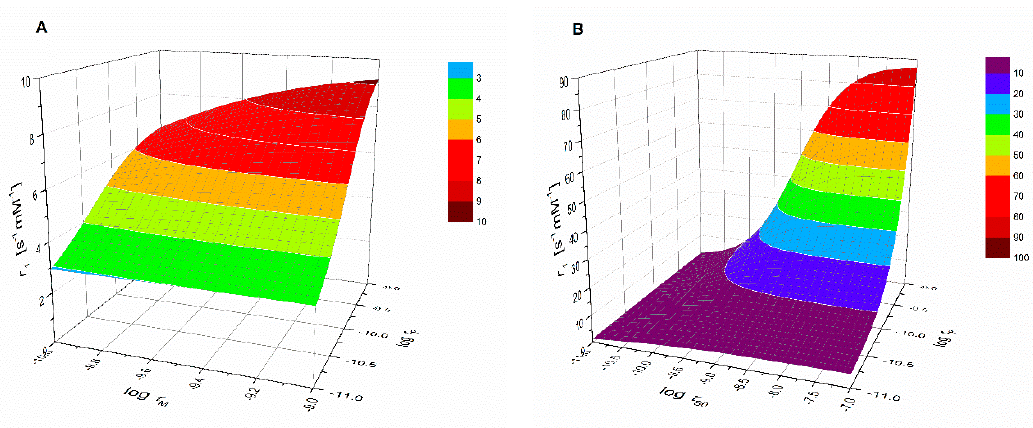
Figure 4. Representations of simulations of r 1 at LF = 0.01 MHz ( A ) as function of τ M and τ R and ( B ) as function of τ S0 and τ R . Solomon-Bloembergen-Morgan (SBM) Equations (1)–(10) were applied using the following parameters: q = 1, r MnH = 2.83 Å, D MnH = 2.31 × 10 − 9 m 2 ·s − 1 , a MnH = 3.6 Å.